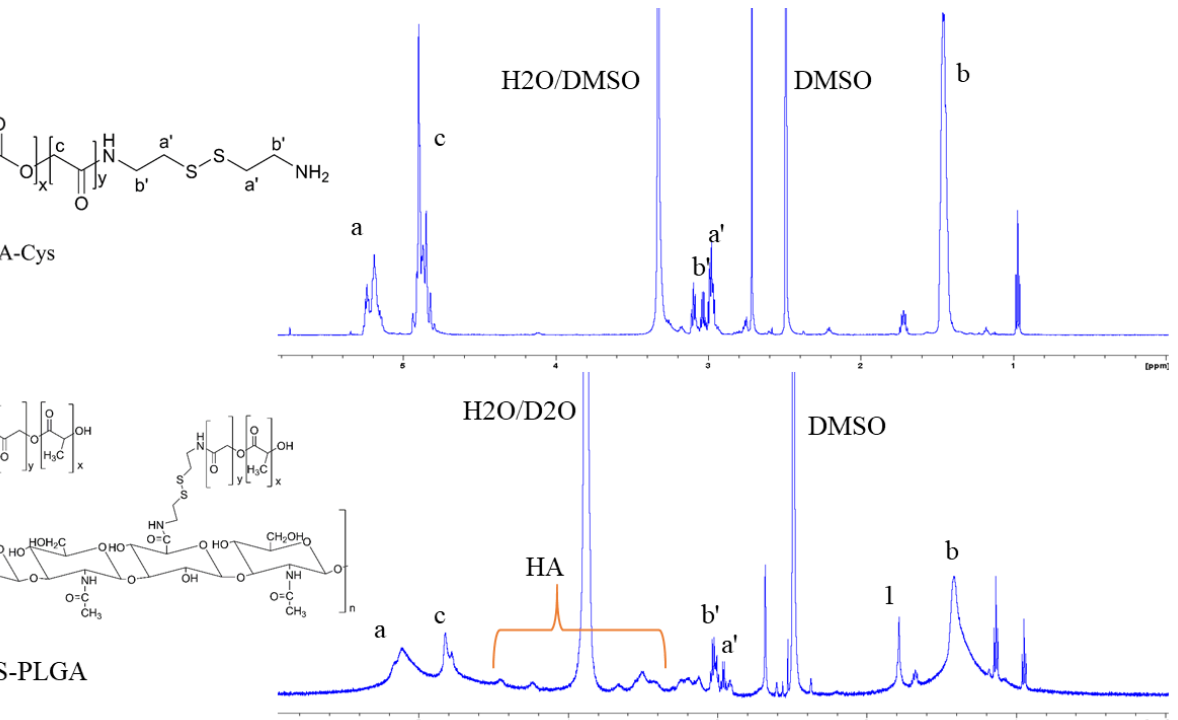
Figure 2. FTIR spectrum of HA-SS-PLGA and its precursors. 3.2. Synthesis and Characterization of AUY922-Loaded Micelle The micelle was formed due to the amphiphilic nature of HA-SS-PLGA (i.e., hydro- philic HA and hydrophobic PLGA) in water. The micelle-forming tendency of HA-SS-